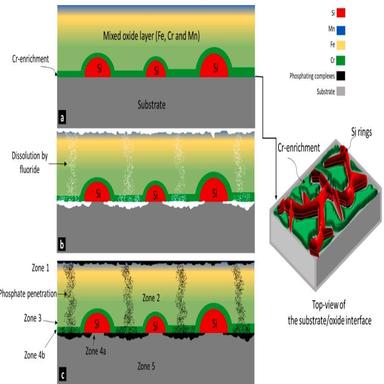
Schematic illustration of the initial state of the thermal oxide film (a), the oxide film after pickling step in fluoride-containing solution (b), and the oxide film after phosphate conversion treatment (c)